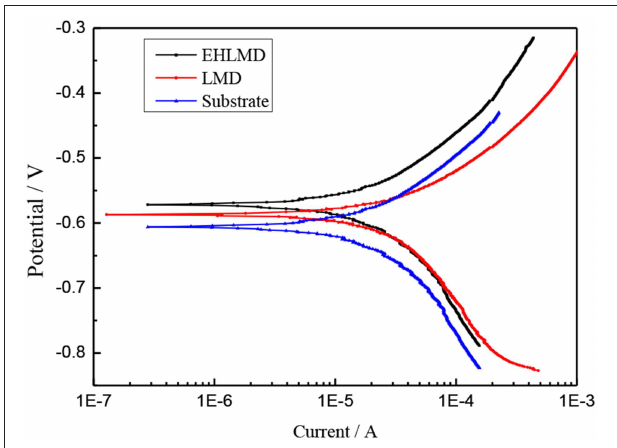
FIGURE 9 | Polarization curves of LMD, EHLMD, and substrate.